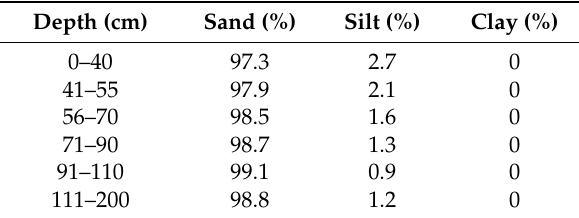
Table 2. Soil texture at the observation